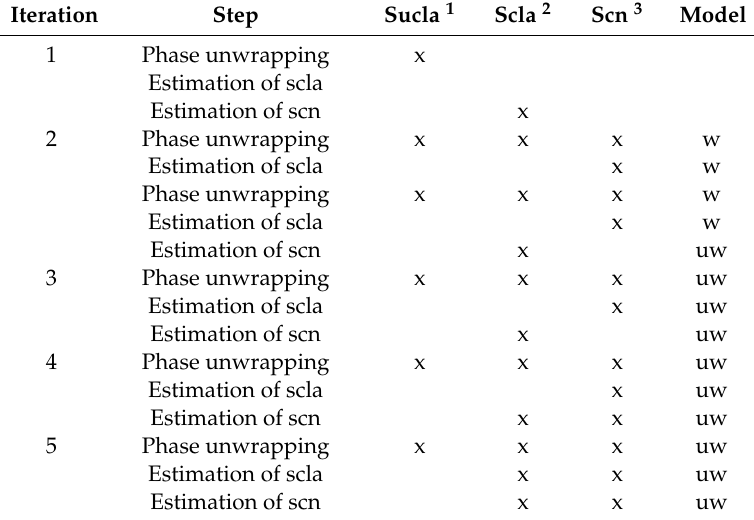
Table 1. Overview of corrections done during iterative